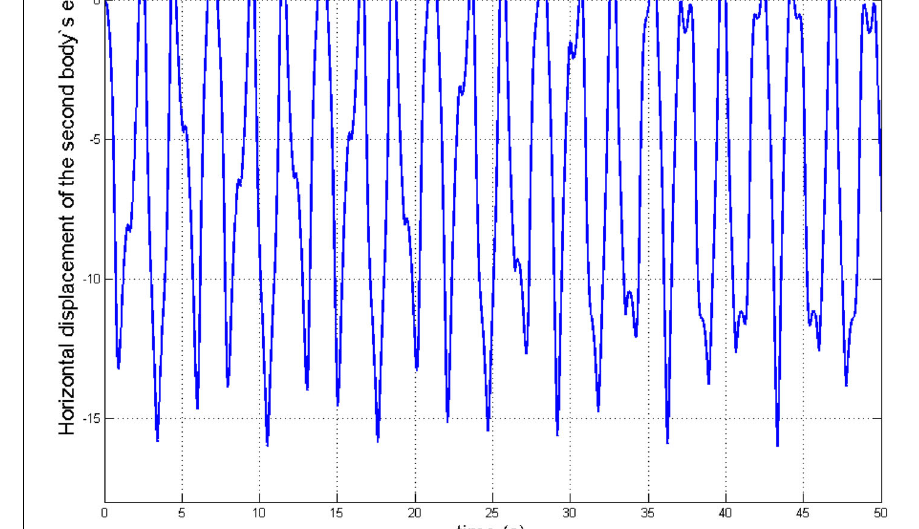
Fig. 33 Horizontal displacement